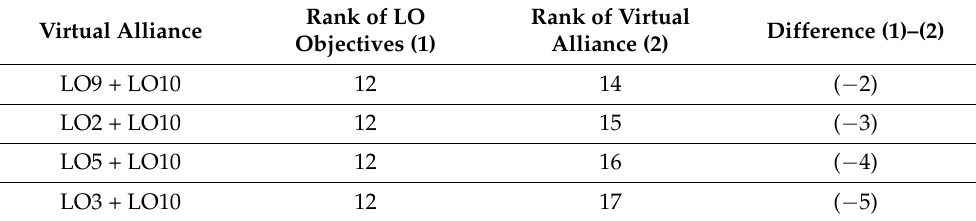
Figure 13. Score efficiency of virtual alliances (source: researcher). Table 10. The alliances are not really suitable (calculated by